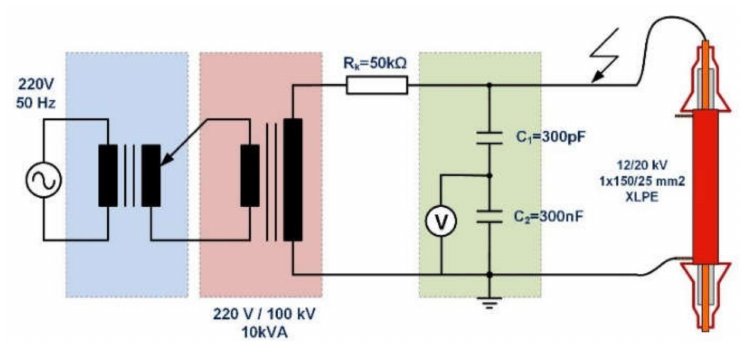
Figure 6. Experimental setup for overvoltage aging.